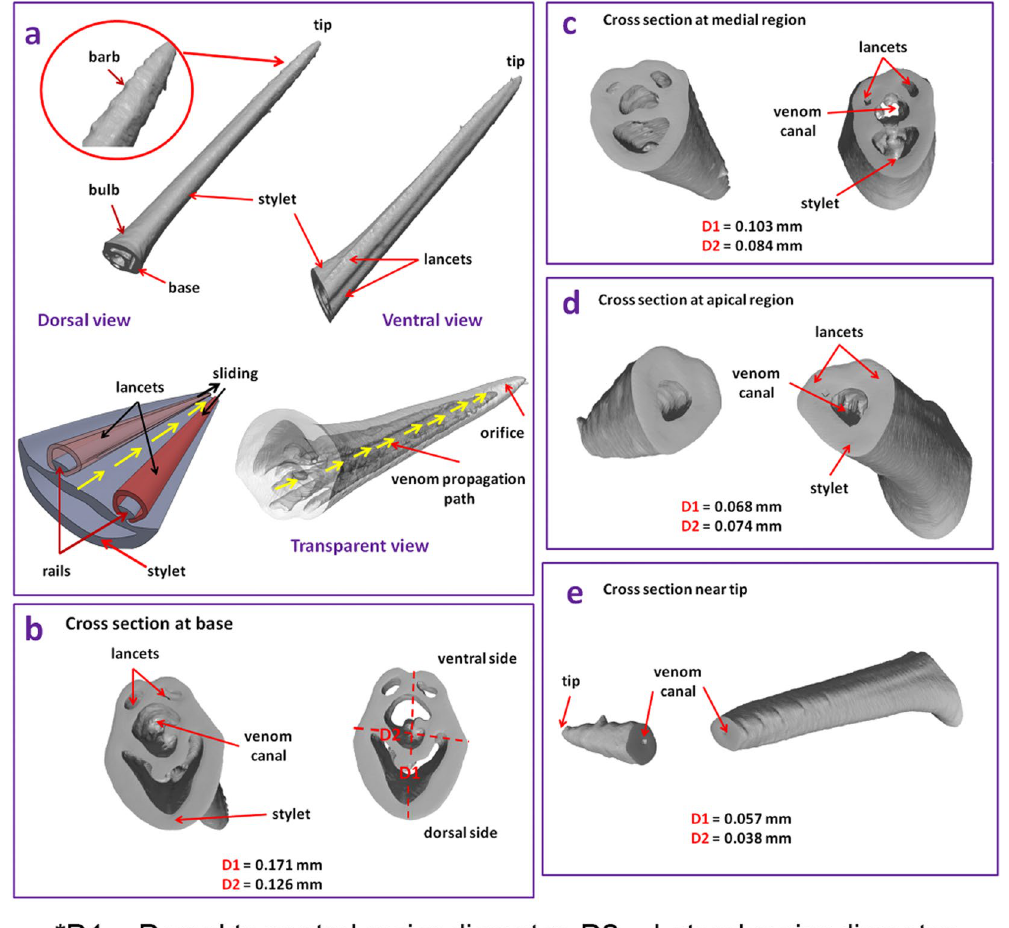
Figure 2. ( a ) Structure of the whole honeybee stinger obtained from micro-CT, ( b ) Cross section at the base, ( c ) Cross section at the medial region, ( d ) Cross section at the apical region, and ( e ) Cross section near the tip. The lancets freely slide onto the rails of the stylet as per schematic representation in ( a ). The stinger penetrates into the victim’s body because of the cooperative alternative motion of the paired lancets and the venom is pumped through the canal into the